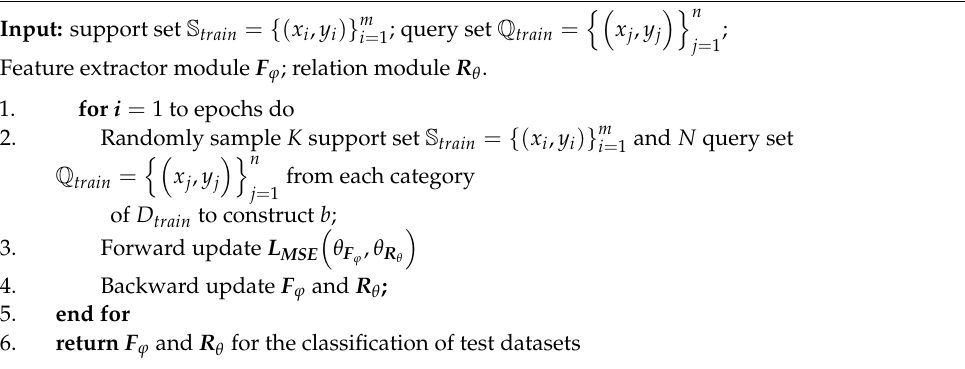
Algorithm 1 . Mini-batch training algorithm for the WRRN. b and epochs denote the batch size and the number of iterations